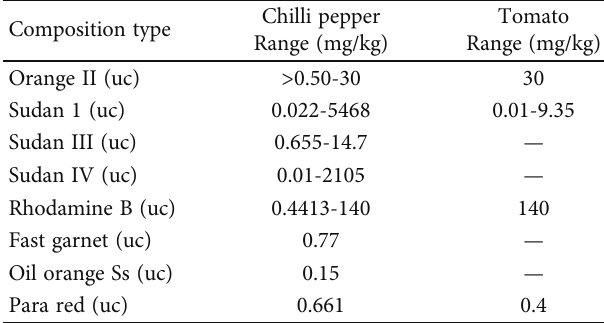
Table 3: Unauthorized dyes present in chilli pepper and tomato as reported by RASFF.